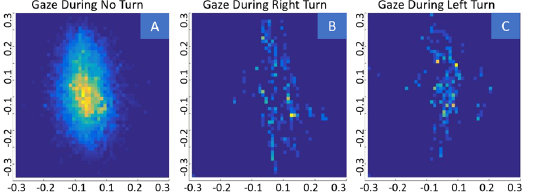
Figure 15: Sample Data of two subjects. (A) Heat map of gazes while the subject is not turning. (B) Gazes in 10 frame time win- dows while the subject is making a right turn >20 degree. (C) Gazes in 10 frame time windows while the subject is making a left turn >20 degree.